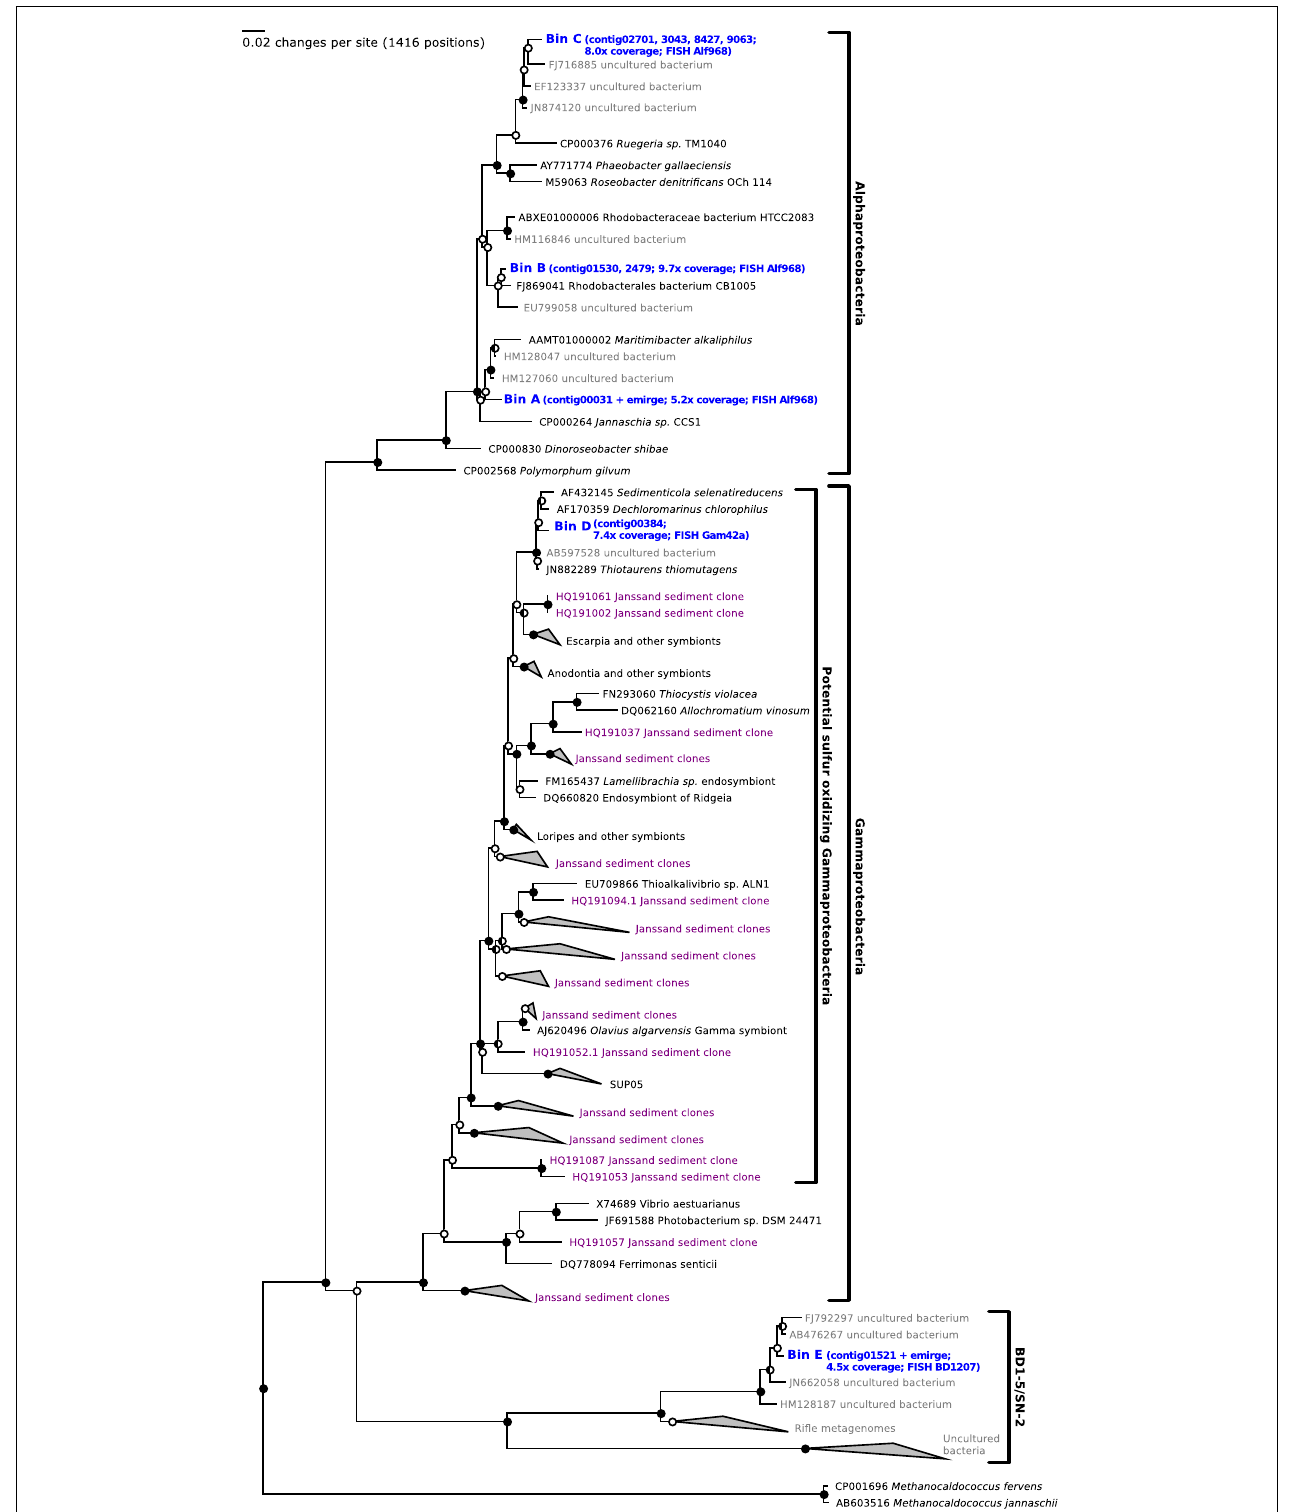
FIGURE 4 | Phylogenetic analysis of the full length ribosomal 16S rRNA genes reconstructed from the metagenome reads sampled after 23 days of selection (blue). Closed circles indicate bootstrap values of > 95%, half